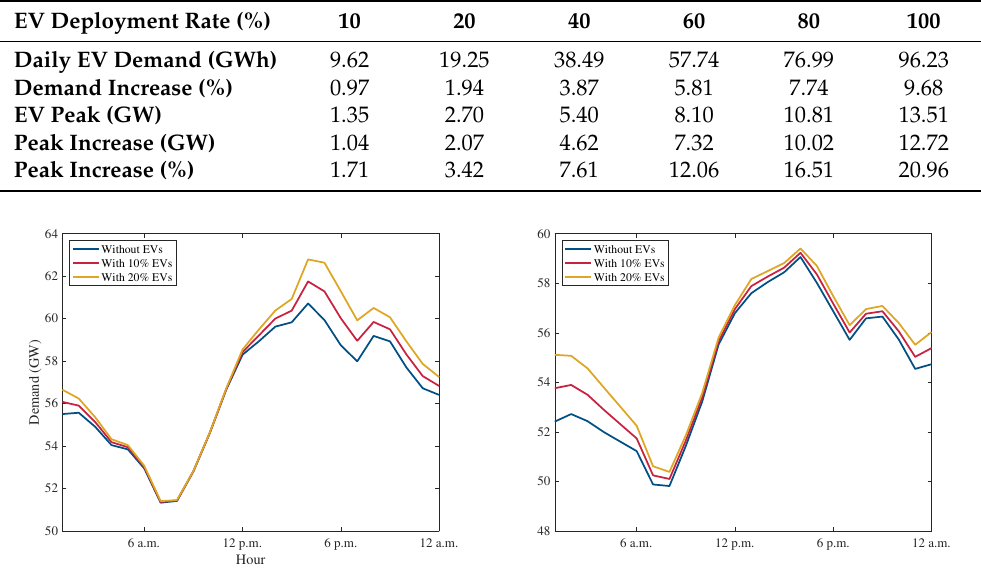
Figure 9. Demand profile on weekdays ( left ) and weekends ( right ) of Saudi Arabia grid with 10 and 20%